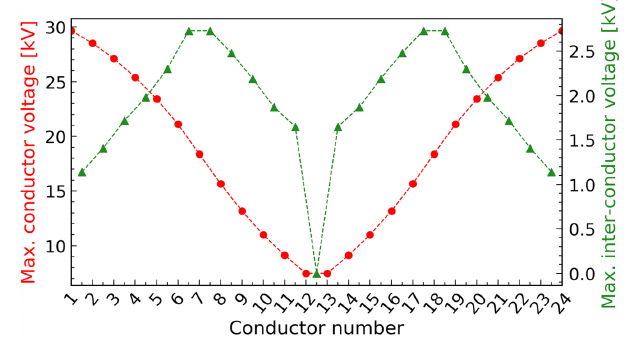
FIG. 6. Maximum conductor (circular markers) and inter- conductor (triangular markers) voltages for 60 kV PFN voltage